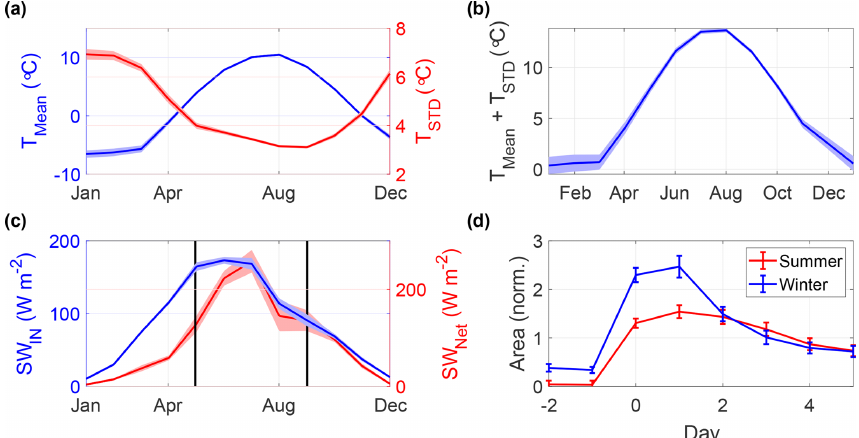
Figure 1. (a) Mean annual cycle of the temperature and its submonthly variability at Station South (location shown in Fig. 2c and d), with envelopes representing the standard error of the mean. (b) Sum of the mean annual cycle of the temperature and its submonthly variability at Station South. (c) Mean annual cycle of the incoming and net (incoming minus outgoing) shortwave radiation at Station South. (d) Composite of the melt extent evolution during summer and winter melt events, normalized by the mean annual cycle and standard deviation.